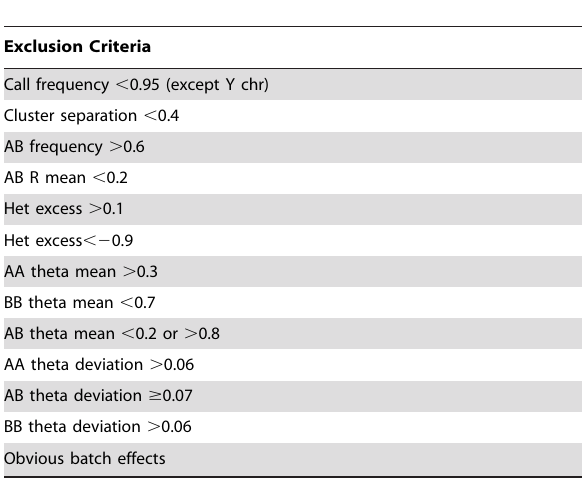
Table 4. Best practices criteria used to identify SNPs for visual inspection and manual reclustering. Best Practices Criteria